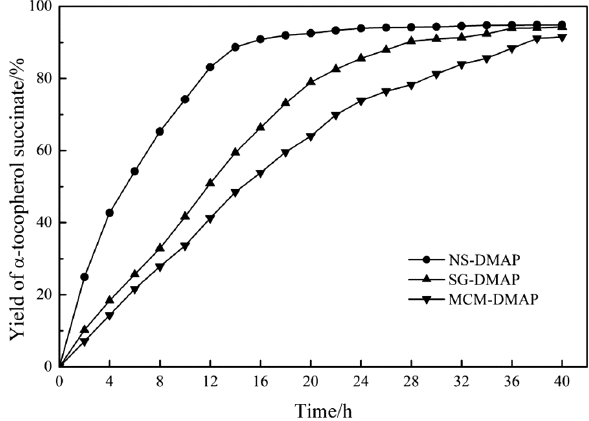
Figure 5: Effect of different carriers. Conditions of reaction: